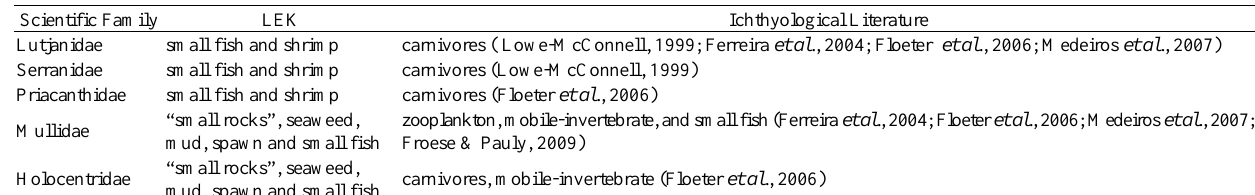
Table 6. Comparison between Local Ecological Knowledge (LEK) and scientific knowledge referring to the feeding habits of the snapper group